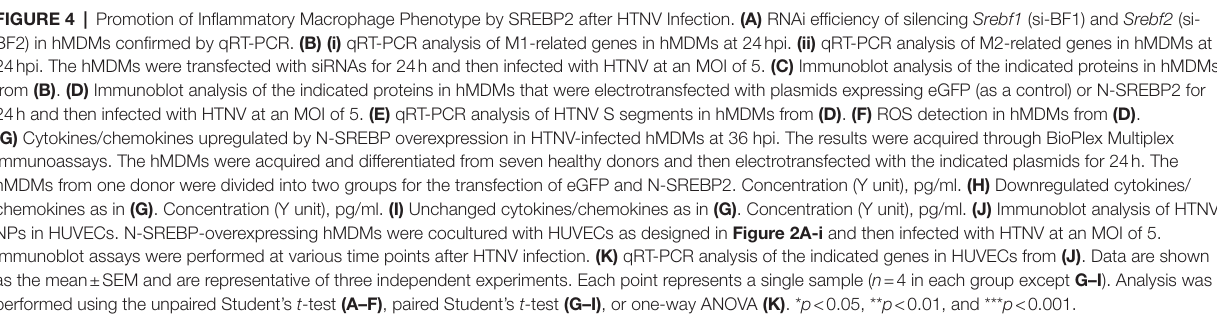
FIGURE 4 | Promotion of Inflammatory Macrophage Phenotype by SREBP2 after HTNV Infection. (A) RNAi efficiency of silencing Srebf1 (si-BF1) and Srebf2 (si- BF2) in hMDMs confirmed by qRT-PCR. (B) (i) qRT-PCR analysis of M1-related genes in hMDMs at 24 hpi. (ii) qRT-PCR analysis of M2-related genes in hMDMs